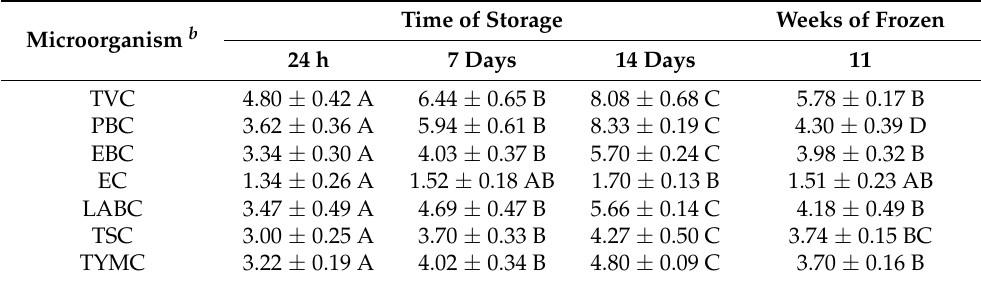
Table 2. Microbiological counts (log CFU/g) of a different microbial group for minced meat of beaver ( n = 6) a